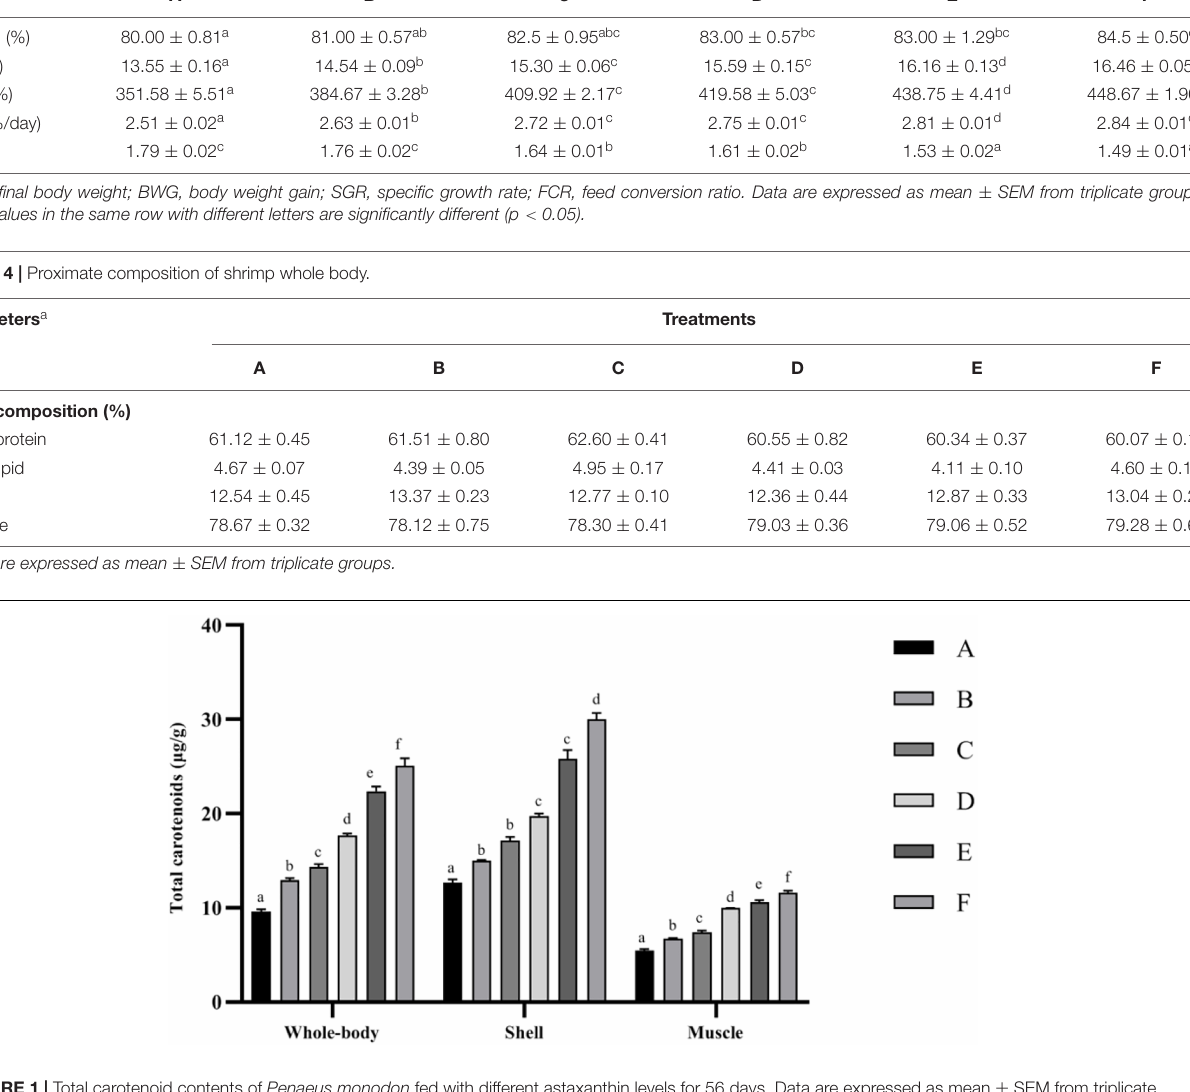
Parameters Treatments